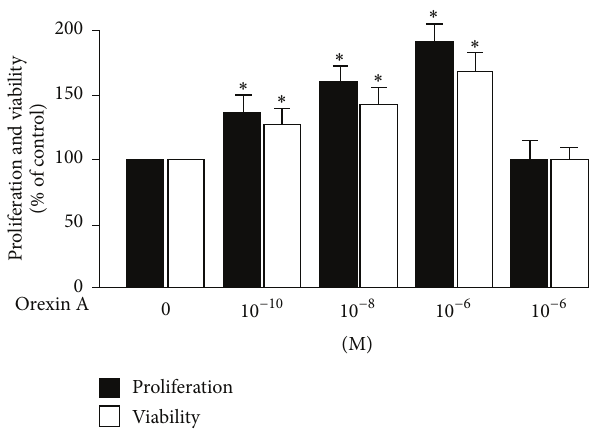
Figure 2: Proliferation and viability of INS-1 cells treated with OXA. Cells were treated with OXA at concentrations of 0M, 10 −8 M, 10 −10 M, and 10 −6 M for 24h. In addition, a separate group of cells was treated with 10 −6 M OXA in the presence of the OX1R antagonist SB334867 (OX1Ri) (10 −6 M) for 24 h. Proliferation and viabilityweredeterminedbyBrdUassaysandtheMTTtest.Dataare presented as mean ± SEM based on triplicate determinations from a representative experiment. Asterisks indicate significant differences compared to control ( ∗ 𝑃 < 0.05) .